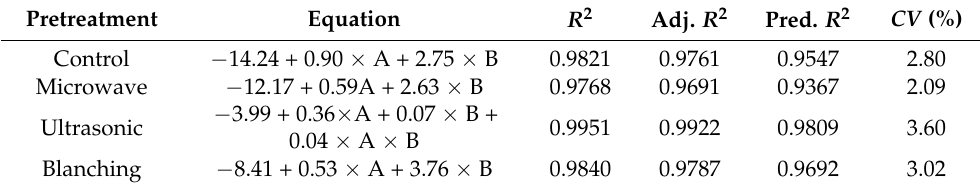
Table 6. RSM modeling for predicting shrinkage of the turnip samples under an HCIR dryer with different